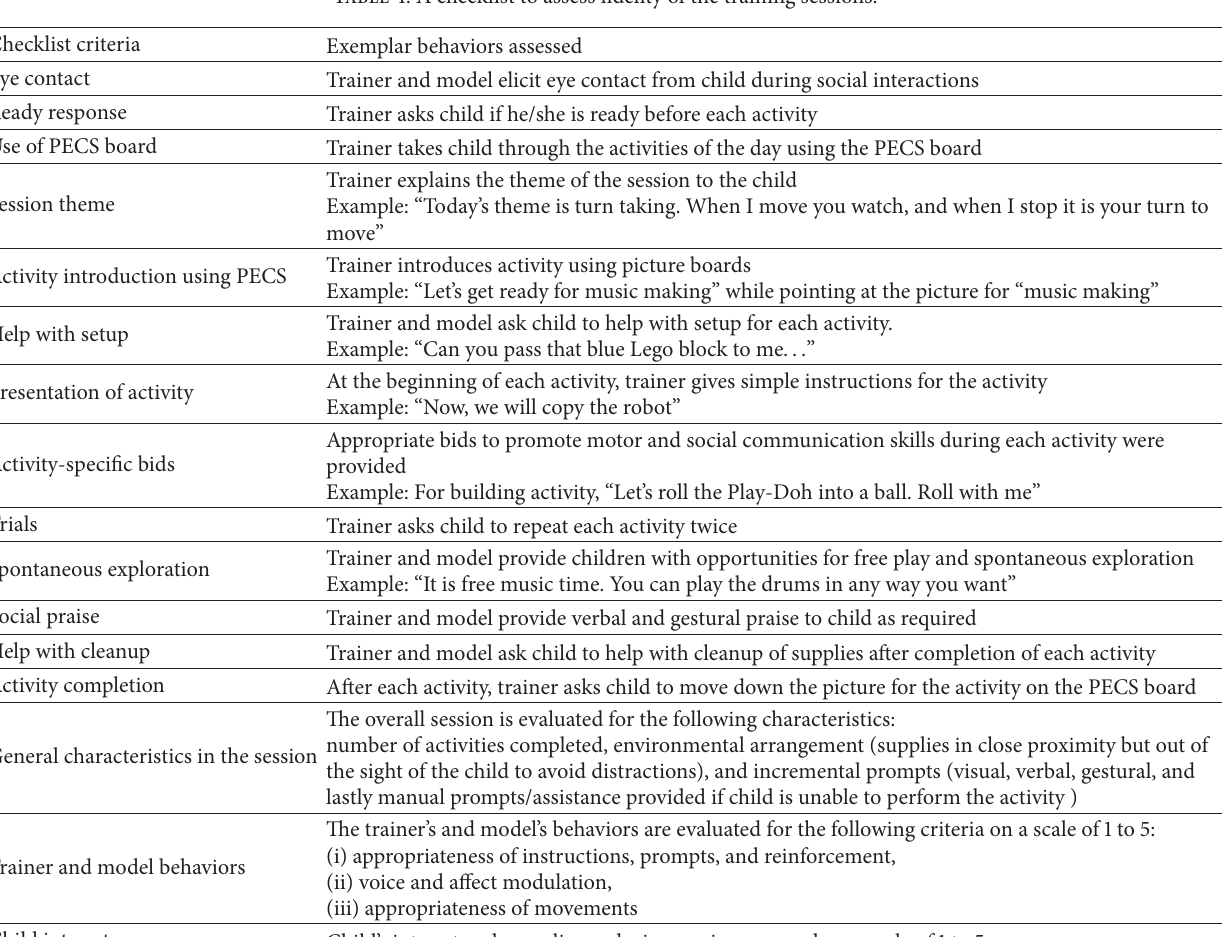
Table 4: A checklist to assess fidelity of the training